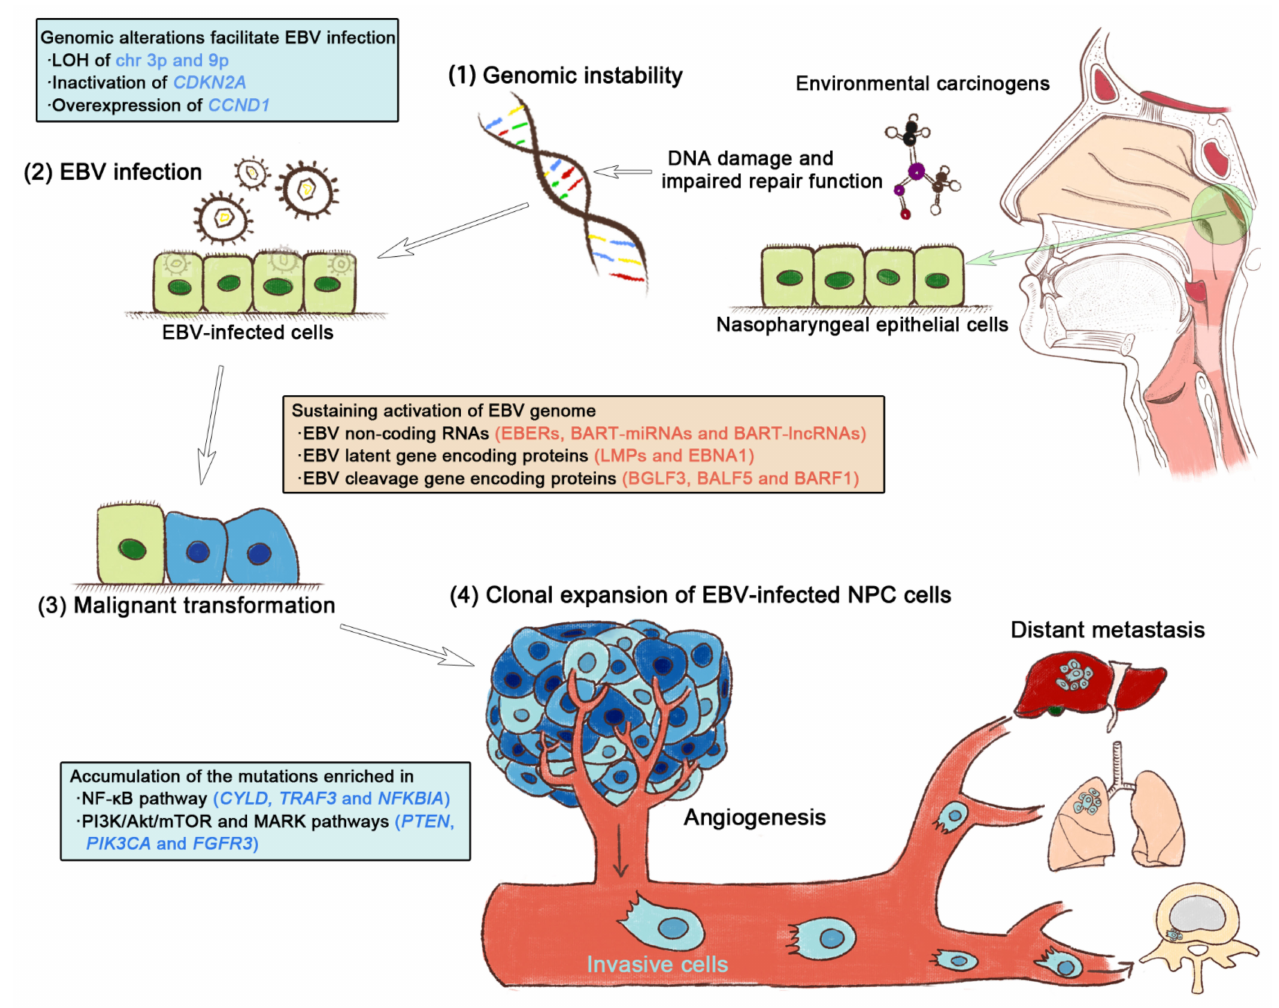
Figure 2. The synergy of host genomic instability and Epstein–Barr virus (EBV) infection drives the multistep NPC progression. ( 1 ) Regional environmental carcinogens, such as nitrosamines and polycyclic aromatic hydrocarbons, induce DNA damage and repair function impairment,